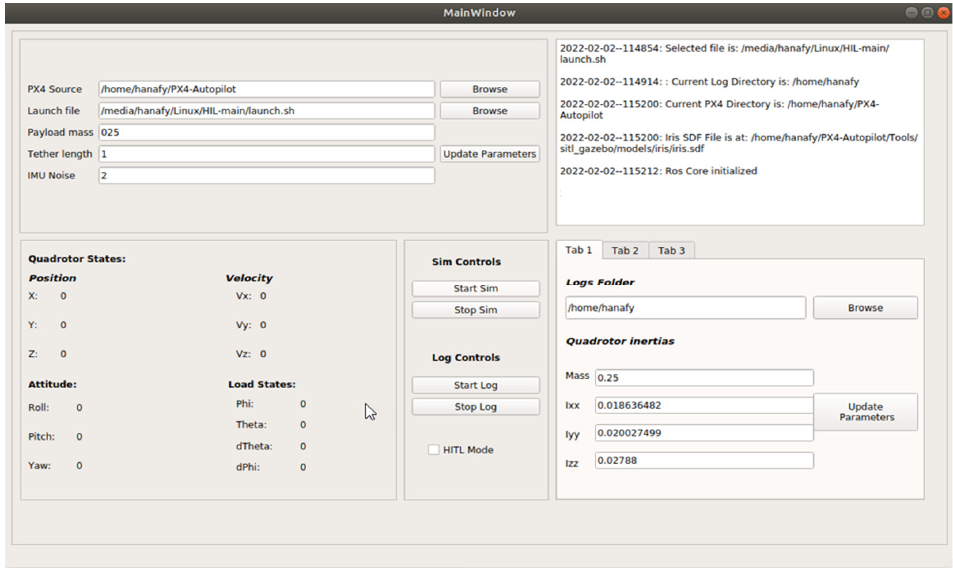
Figure 12. Simulation GUI interface.